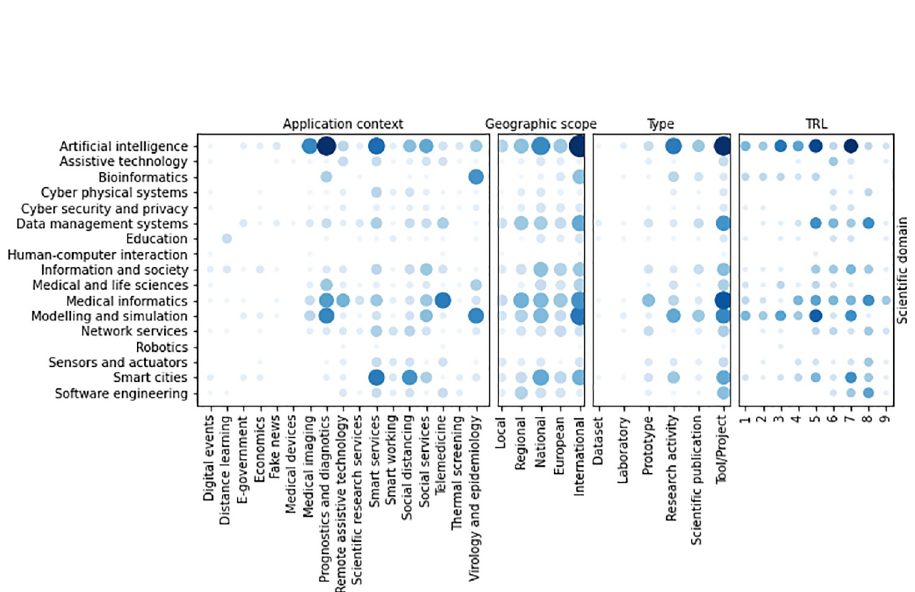
Fig 12. Co-occurrence of scientific domains with the other categorisations.